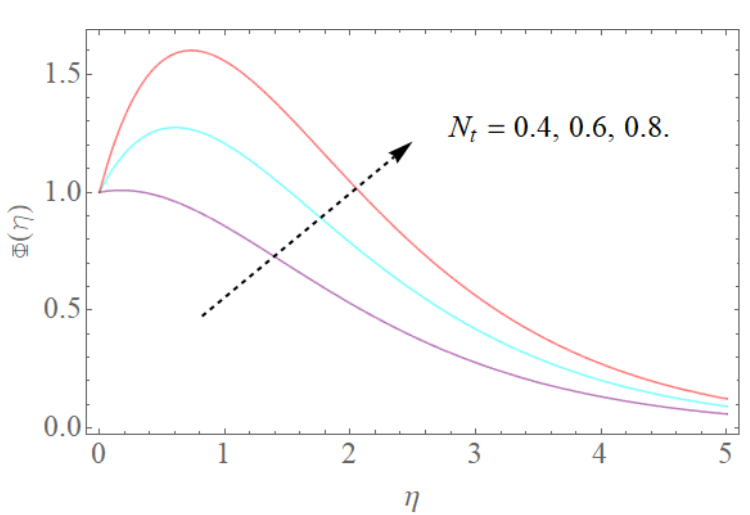
Figure 14. The effect of N b on